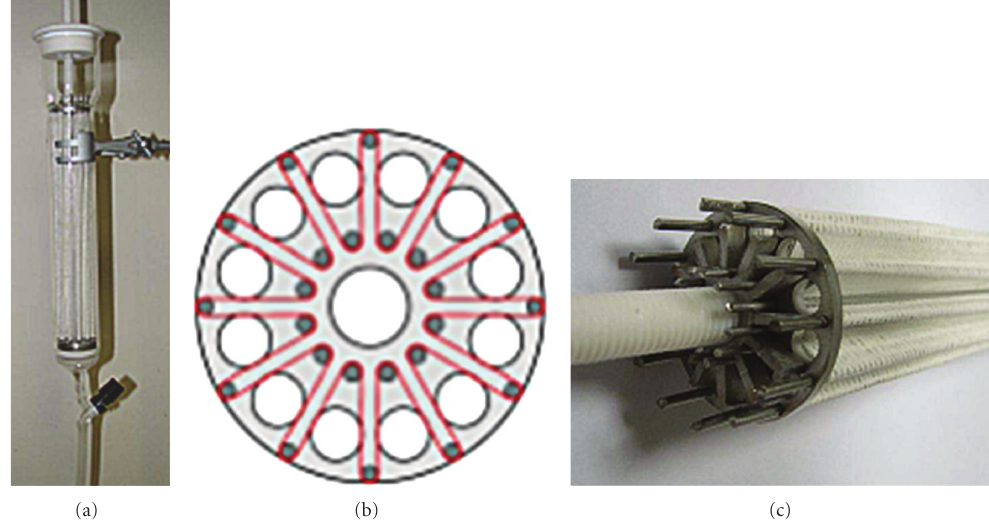
Figure 2: (a) Photocatalytic cell with the glass tube. (b) Geometrical shape of the steel paper holder (top view). (c) Photocatalytic paper fixed to the steel holder. Table 1: Characteristics of untreated and pretreated textile wastewater, subjected to photocatalysis. Untreated sample CW-pretreated sample Parameter Blue Red Black Blue Red Black Absorbance at max intensity in Vis 0.88 at 592 nm 1.99 at 520 nm COD [mg/L]